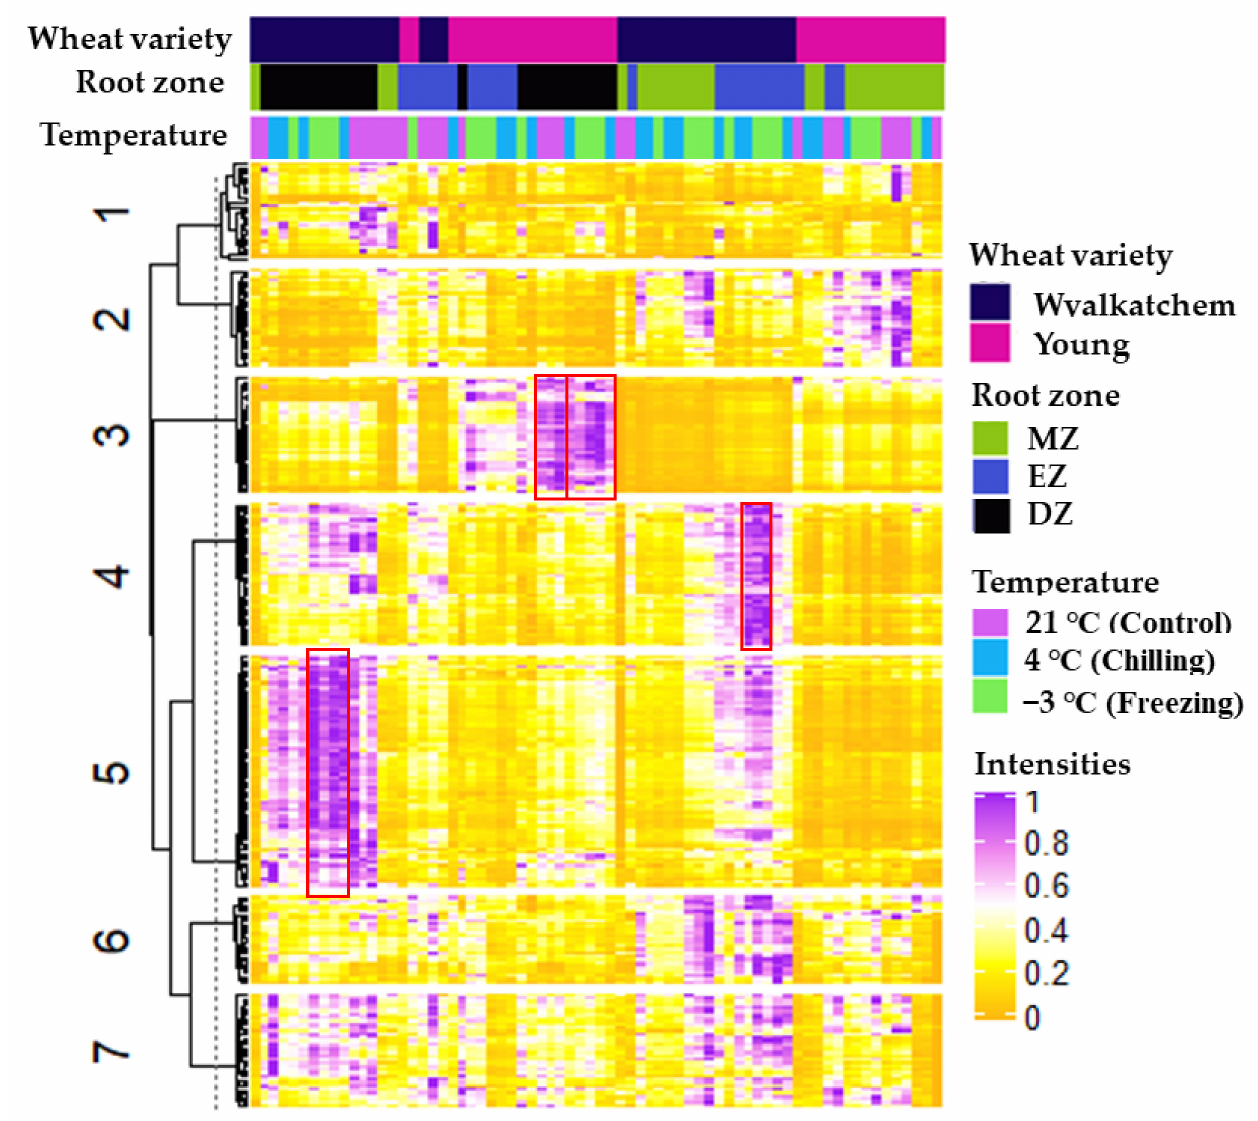
Figure 4. Bootstrapped hierarchical clustering analysis (HCA) of lipid autoscaled intensities from all the root samples (control and subjected to cold stress for three developmental root zones) of cold-sensitive Wyalkatchem and cold-tolerant Young varieties. Rows were clustered using K-means with K equal to 7, and with n clustering reiterations ( n = 1000). R packages ComplexHeatmap and pvclust were used to do and extract the heatmap image